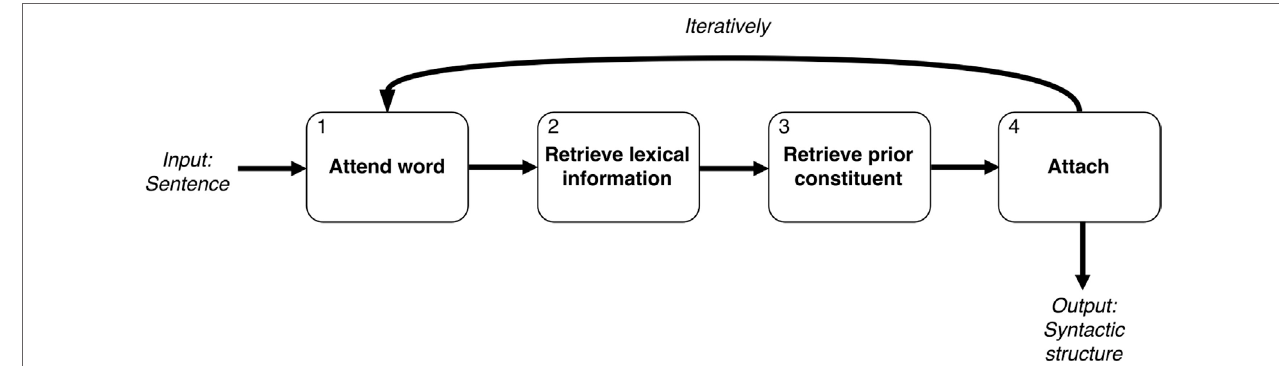
FigURe 4 | Overview of the processing steps of L&V’s sentence processing model [based on Lewis and Vasishth (2005)]. The model processes one word at a time when processing a sentence such as Example (1), first retrieving its lexical information and then retrieving a prior constituent for the new word to be attached